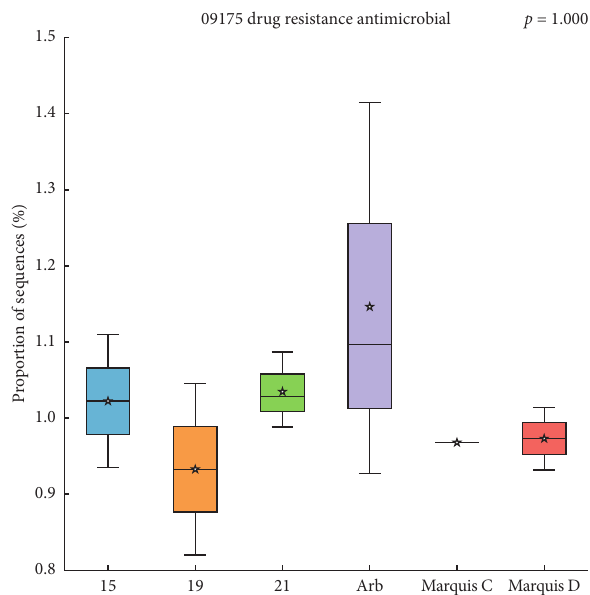
Figure 11: Comparison by field of proportion of sequences in the antimicrobial drug resistance pathway.